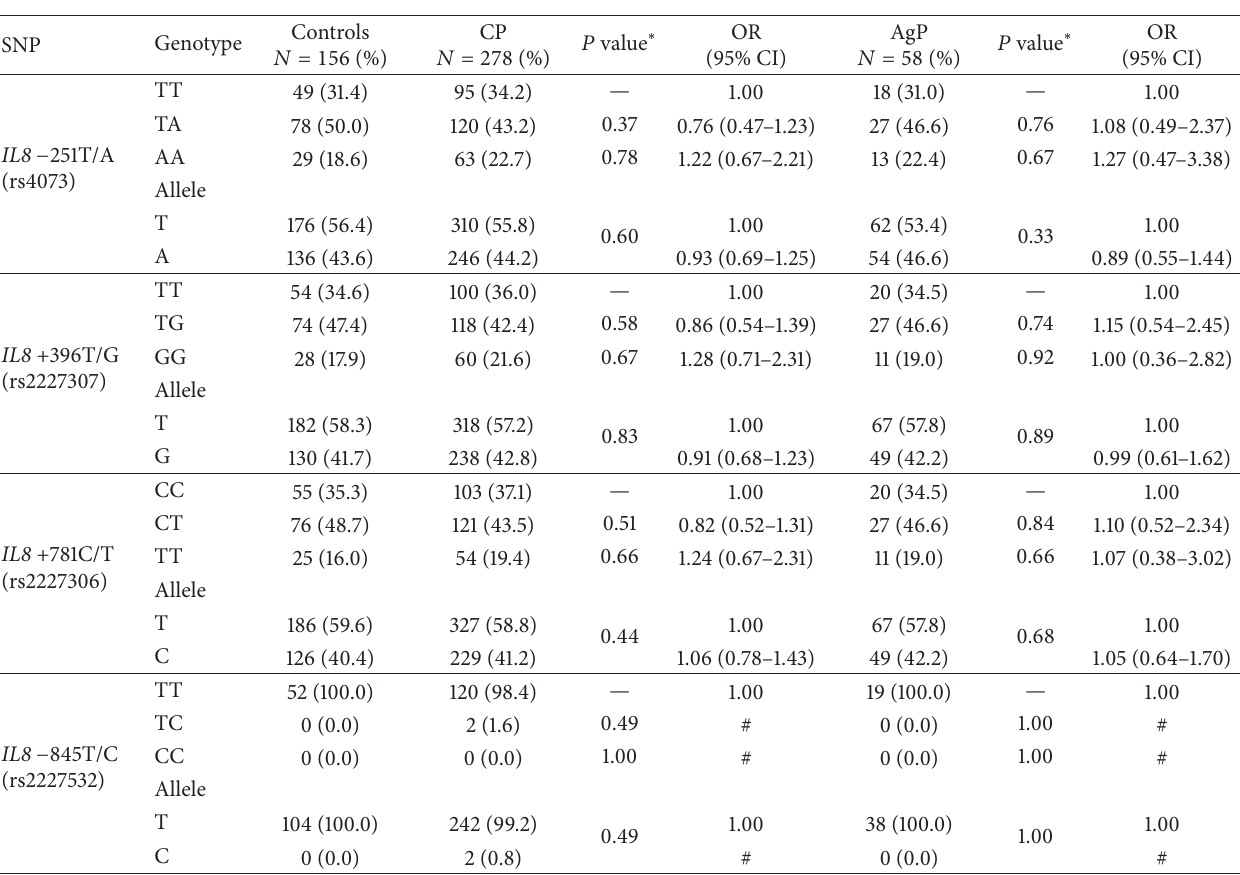
∗ Differences between individual haplotypes (between controls and CP or controls and AgP) were analyzed using the Fisher exact test. OR:oddsratioadjustedforage,sex,andsmokinginlogisticregression,referencecategoriesdesignatedwithanORof1.0;CI:confidenceinterval, # nonapplicable (small numbers); # OR not calculated because of the presence of zero